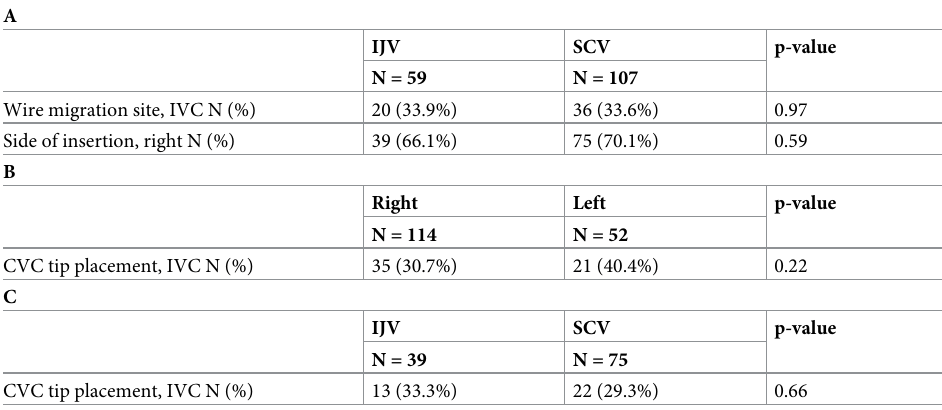
Table 3. CVC insertion site and